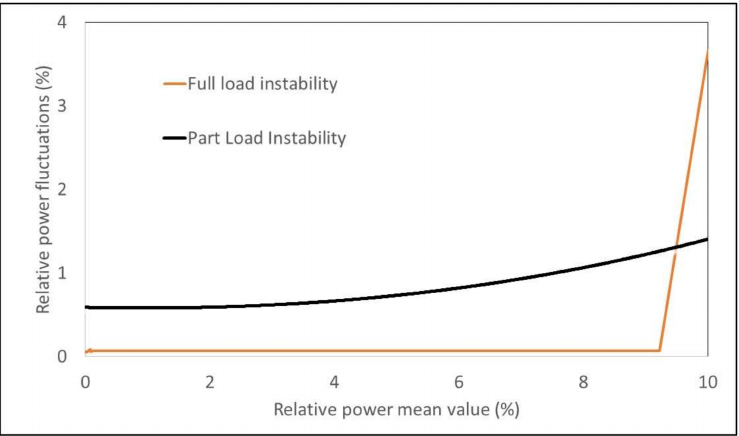
Figure 1. Relative power fluctuations before reaching the part load instability and the full load